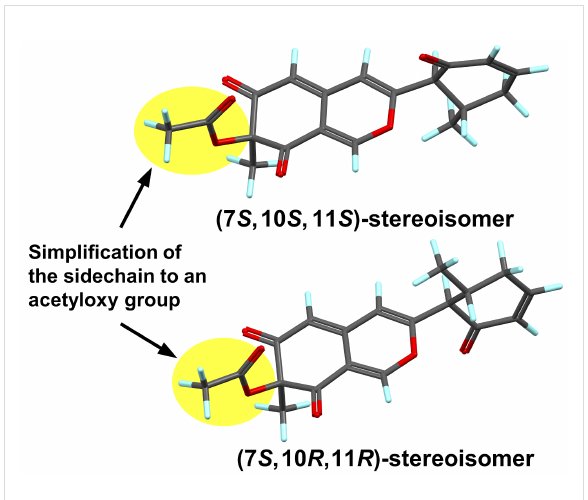
Figure 3: Simplified model structures for calculations of the ECD spec- tra of 1